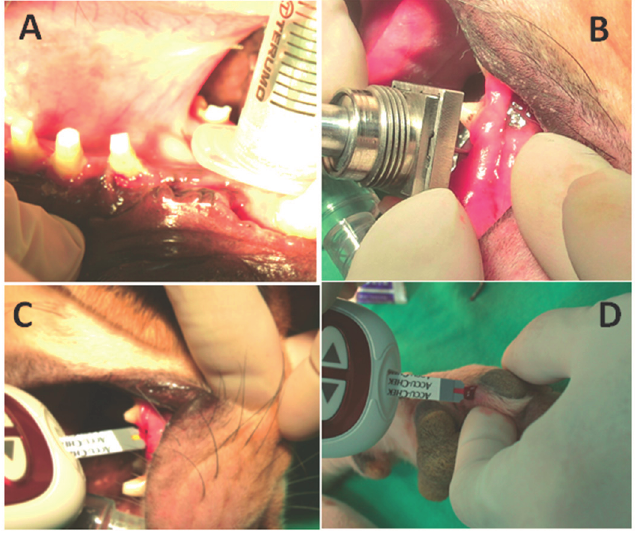
Figure 5. The canine model for blood sugar monitoring. ( A ) The wound exposure after 1 month for further implant placement; ( B ) The DDS and biosensor module for insulin releasing and blood sugar monitoring through the maxillary pathway; ( C ) Blood sugar calibration via the maxillary pathway by ACCU-CHEK® blood sugar detector; ( D ) Blood sugar detection via the anterior